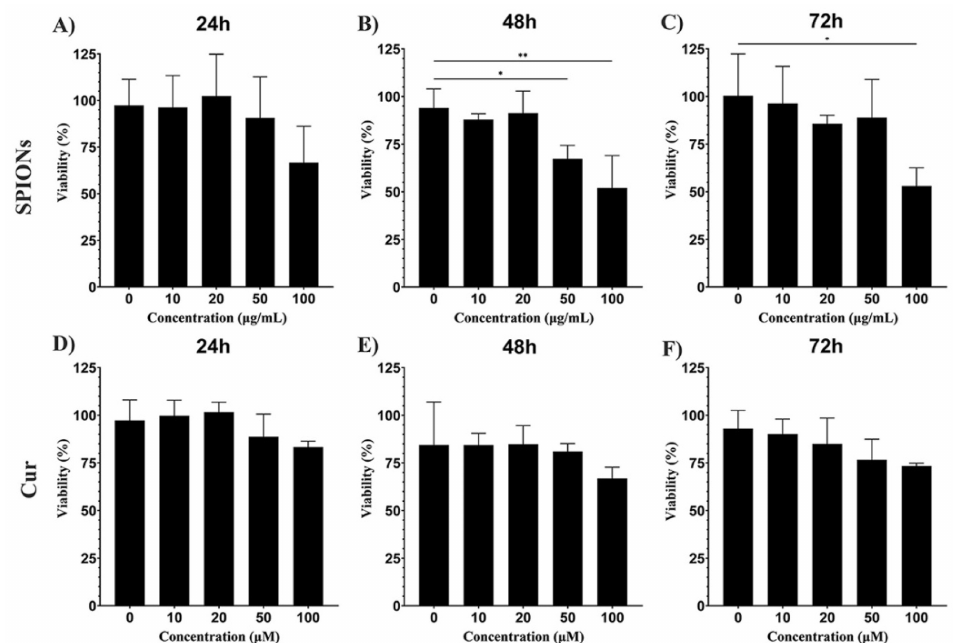
Figure 2. Effects of SPIONs and curcumin on the bioavailability of PC12 cells. ( A ) 24, ( B ) 48, and ( C ) 72 h after treatment of PC12 cells with 10, 20, 50, and 100 µ g/mL. ( D – F ) PC12 cells were treated with 10, 20, 50, and 100 µ g/mL curcumin for 24, 48, and 72 h. Data are presented as the mean ± SD, n = 3, * p < 0.05, and ** p < 0.01 vs. the control